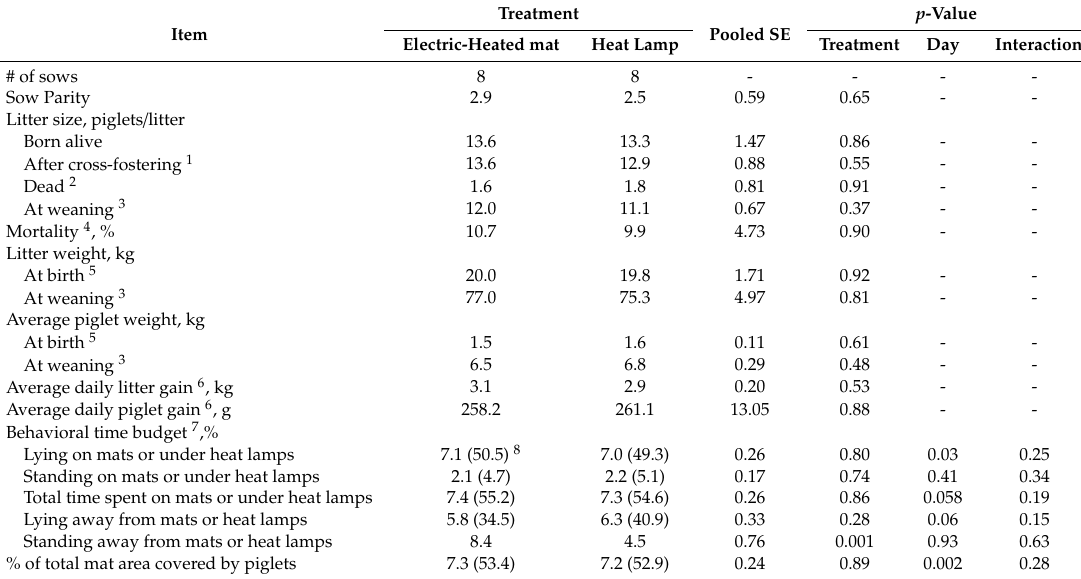
Table 3. Behavior and performance of piglets using electric-heated mats or heat lamps (Trial 2). p -Value Treatment Item Pooled SE Electric-Heated mat Heat Lamp Treatment Day